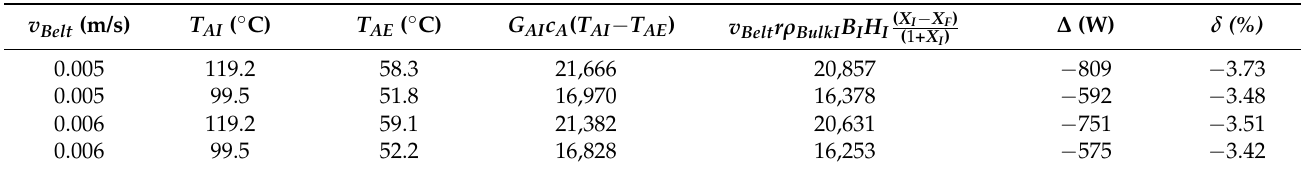
Table 4. Comparison between the heat transfer rate from hot air and the heat transfer rate to produce superheated steam at temperature of the air T A .